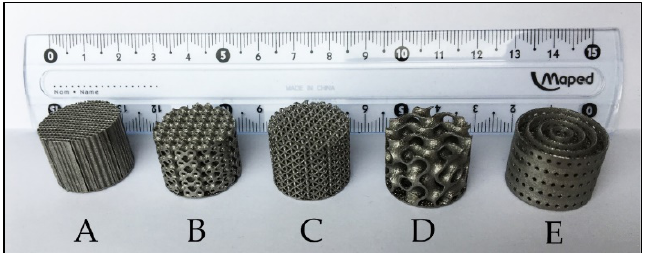
Figure 2. Scaffolds (their weight indicated in parentheses) with: ( A ) Rectangular (3.97 g), ( B ) Primitive (5.35 g), ( C ) Lattice (3.78 g), ( D ) Gyroid (4.04 g) and ( E ) Honeycomb (5.52 g) structures with 20 mm diameter and 15 mm height manufactured by selective laser melting.